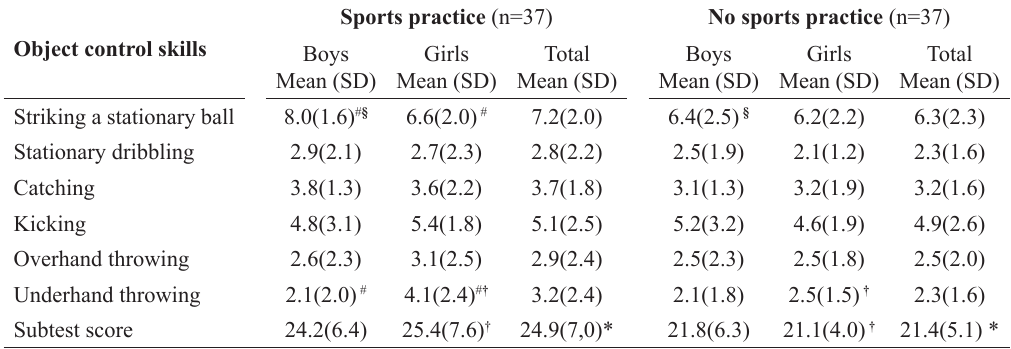
3. Mean and standard deviation (SD) from preschoolers boys’ and girls’ object control skills performances in the sports practice (SP) and no sports practice (NSP)